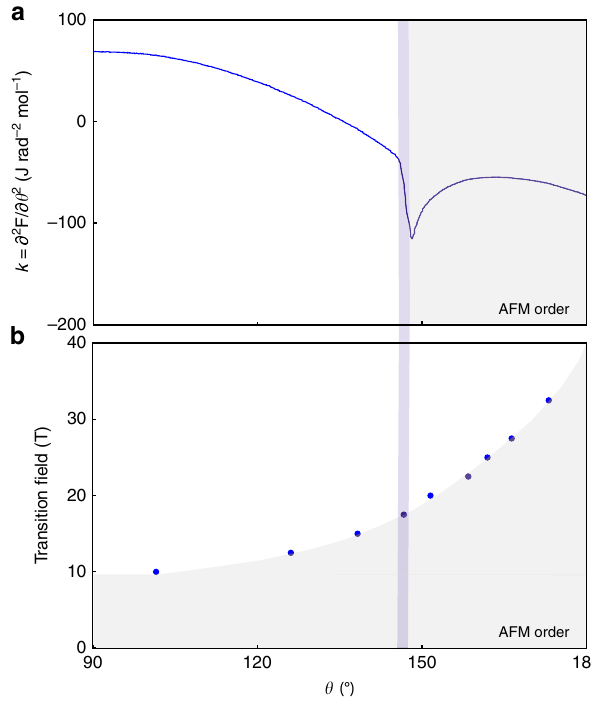
Fig. 5 Anisotropic phase boundary in RuCl 3 . a The magnetotropic coef fi cient k of RuCl 3 at T = 1.3 K and B = 17.5 T as magnetic fi eld is rotated from the honeycomb planes ( θ = 90°) to the perpendicular orientation.